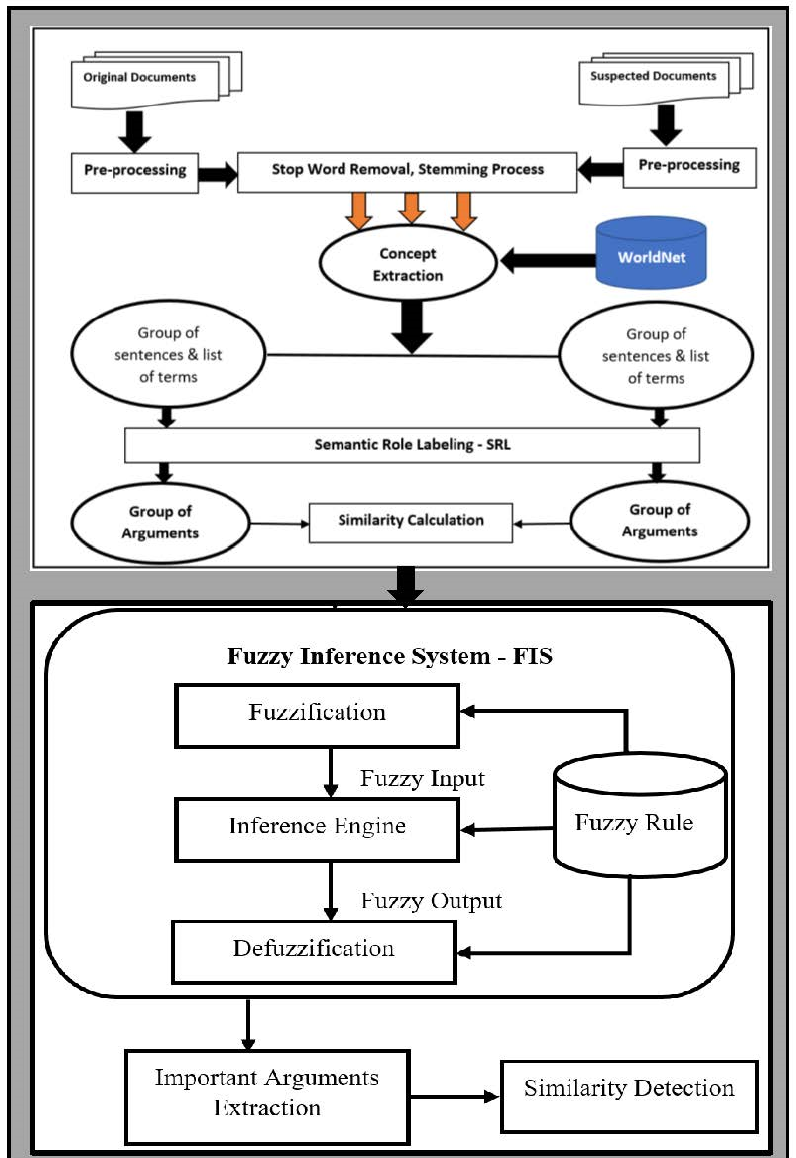
Figure 2. Fuzzy semantic approach to detecting plagiarism.